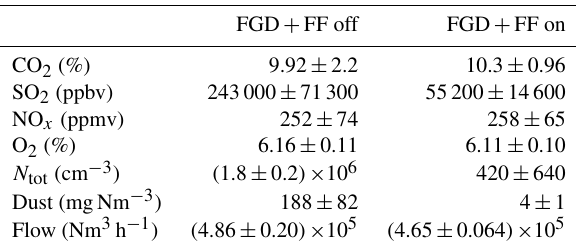
Table 1. Flue-gas concentrations of CO 2 , SO 2 , NO x , O 2 , total parti- cle number ( N tot ), dust and flue-gas flow rate in the stack. Mean val- ues (and standard deviation) are presented for both flue-gas cleaning conditions (FGD + FF on and FGD + FF off).